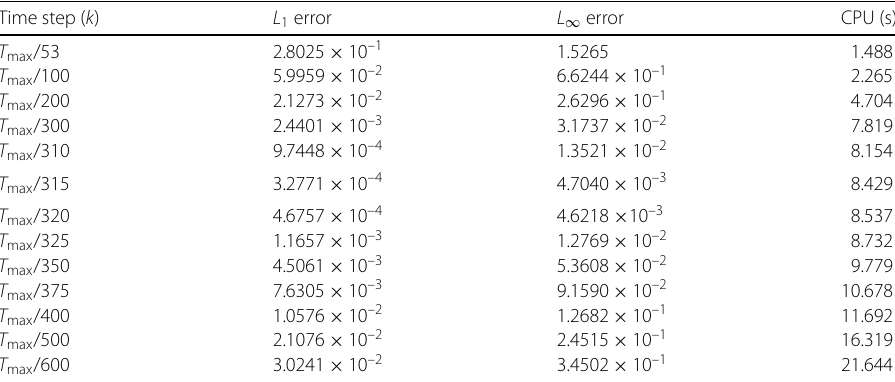
Table 5 L 1 and L ∞ errors and CPU time at some different values of time-step size k and spatial mesh size h = 0.01, (cid:5) = 0.01 of Problem 2 using FTCS- (cid:5) , where T max = 2.5 × 10